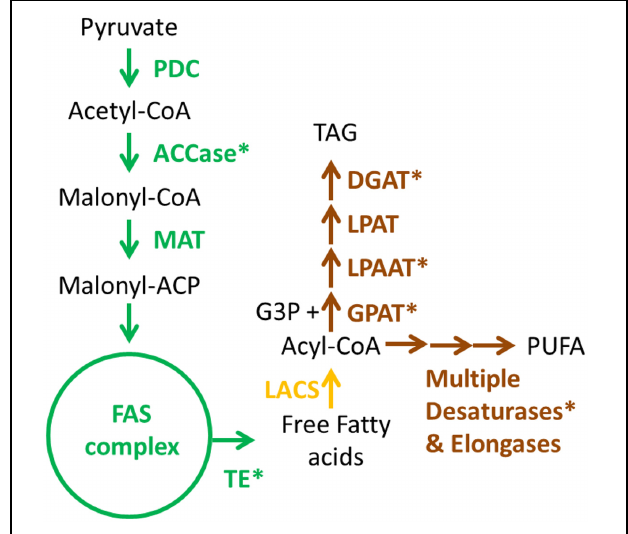
FIGURE 2 | Simplified biosynthetic pathways for fatty acids (FAs), triacylglycerols (TAGs) and polyunsaturated FAs in green microalgae. Enzyme names are colored according to their localization. Green: plastid; Yellow: cytoplasm; Brown: endoplasmic reticulum. Asterisks denote enzymes which have been targeted for metabolic engineering, as shown in Table 1 . PDC, pyruvate dehydrogenase complex; ACCase, acetyl-CoA carboxylase; MAT, malonyl-CoA/ACP transacylase; ACP, acyl-carrier protein; LACS, long-chain acyl-CoA synthetase; FAS, FA synthase; TE, fatty acyl-ACP thioesterase; GPAT, glycerol-3-phosphate acyltransferase; LPAAT, lyso-phosphatidic acid acyltransferase; LPAT, lyso-phosphatidylcholine acyltransferase; DGAT, diacylglycerol acyltransferase; CoA, coenzyme A; G3P, glycerate-3-phosphate; TAG, triacylglycerol; PUFA, polyunsaturated